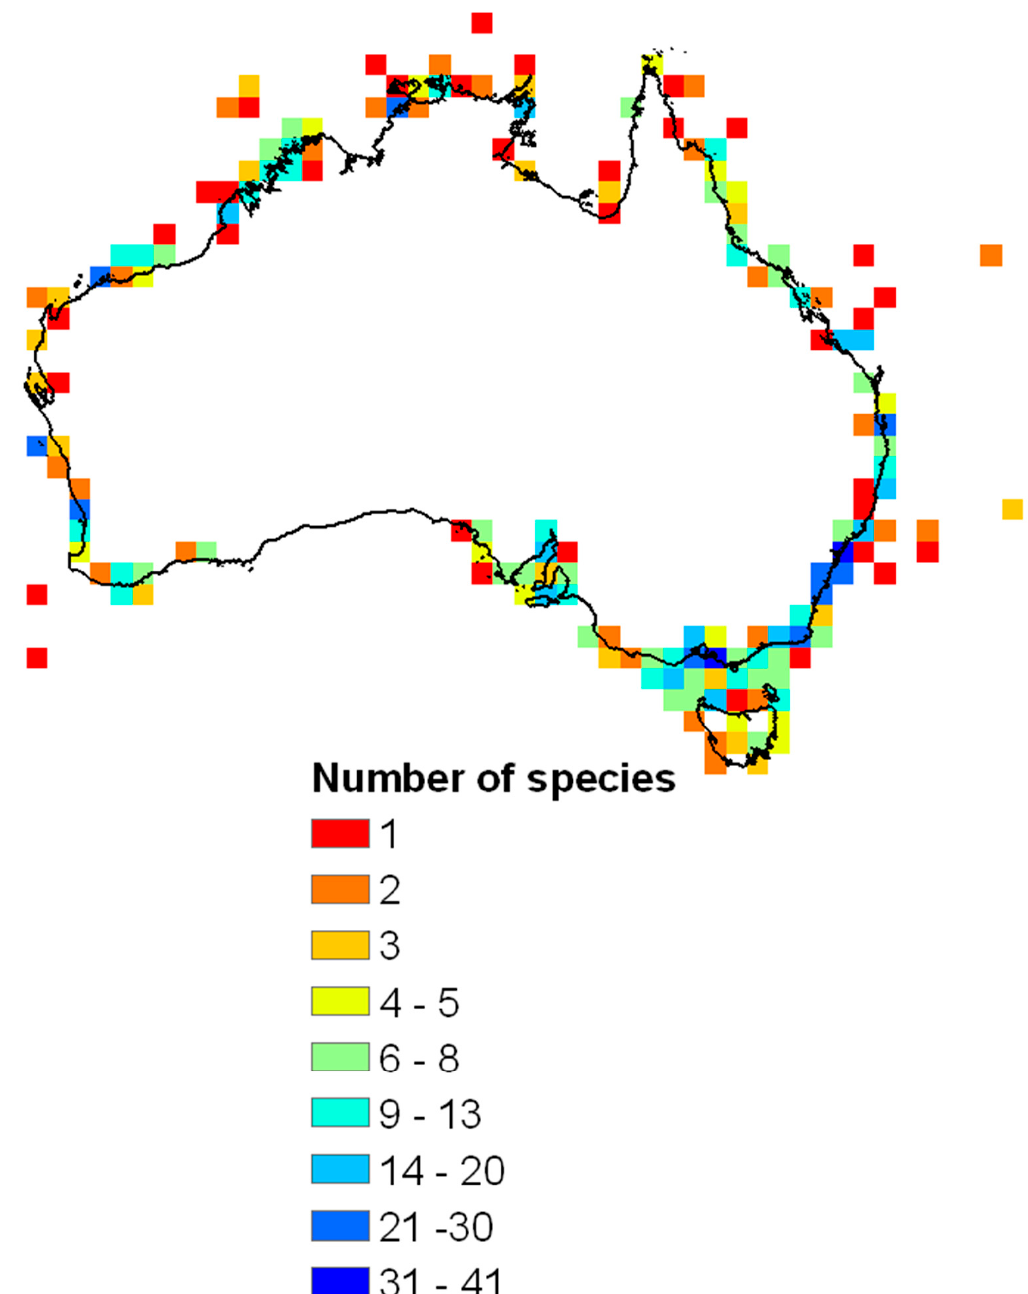
Figure 11. The distribution of terebellids ss. species around Australia based on data from ALA. Supplementary Materials: The following are available online at https://www.mdpi.com/1424-281